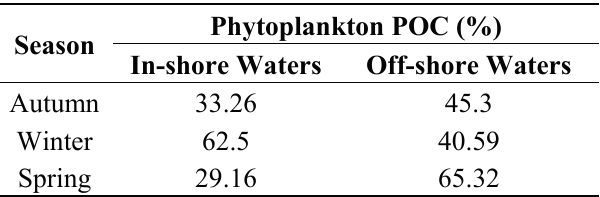
Figure 10. Correlation between POC concentrations and Chl- a concentrations for stations located in off-shore areas, where waters were deeper than 18 m (Figure 1). Summer data are not included. Table 3. Contribution of phytoplankton to POC in different seasons and water types. Chl- a data was not available for the summer cruise. Off-shore waters contained stations with waters deeper than 18